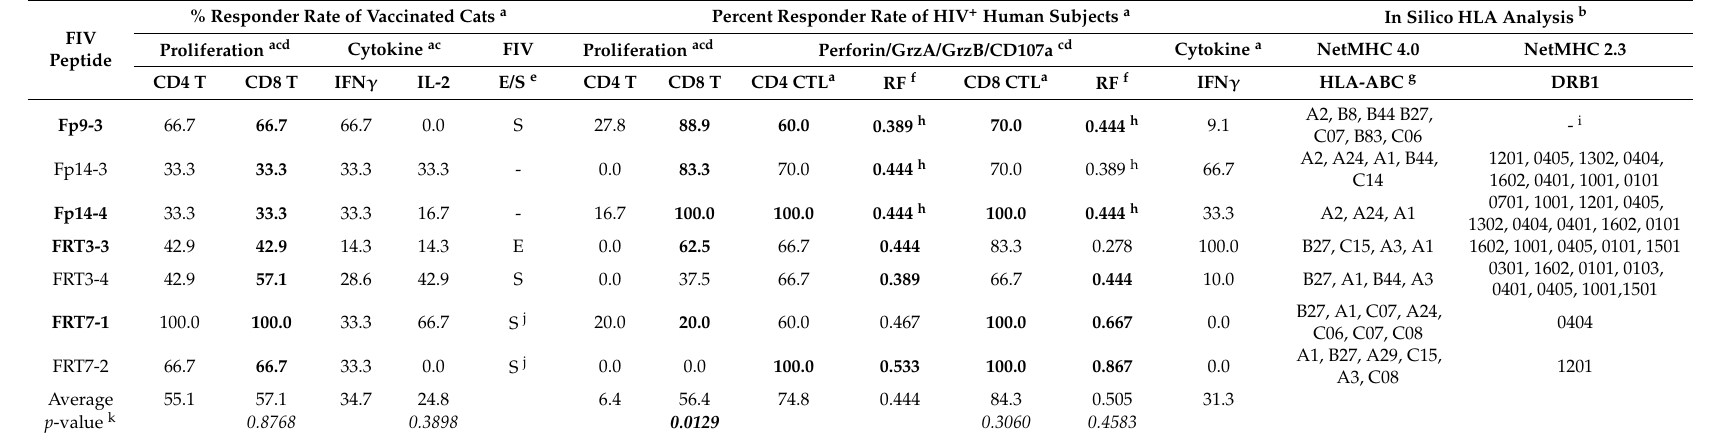
Table 2. Comparative immunogenicity analyses of FIV peptides to identify conserved protective T-cell epitopes. FIV